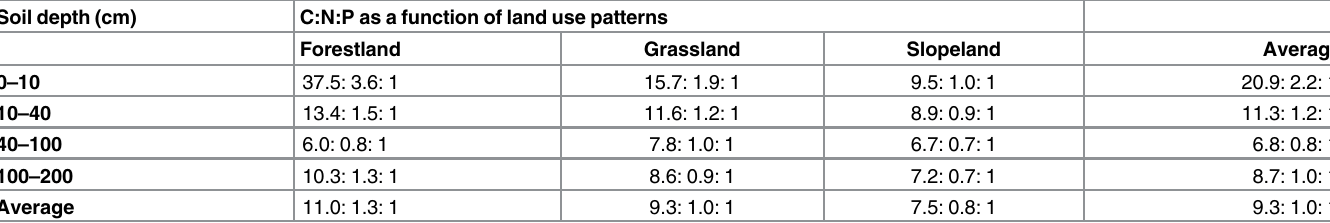
Table 2. Stoichiometry of soil C:N:P as affected by land use patterns and soil depth. Soil depth (cm)